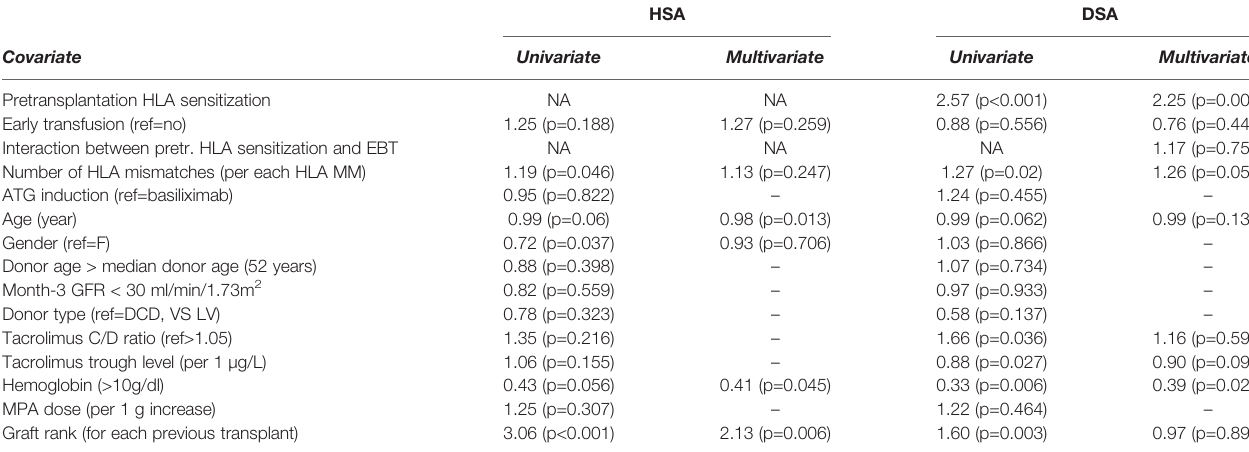
TABLE 4 | Survival analysis for DSA: univariate and multivariate models, hazard ratios ( p -values). HSA DSA Covariate Univariate Multivariate Univariate Multivariate